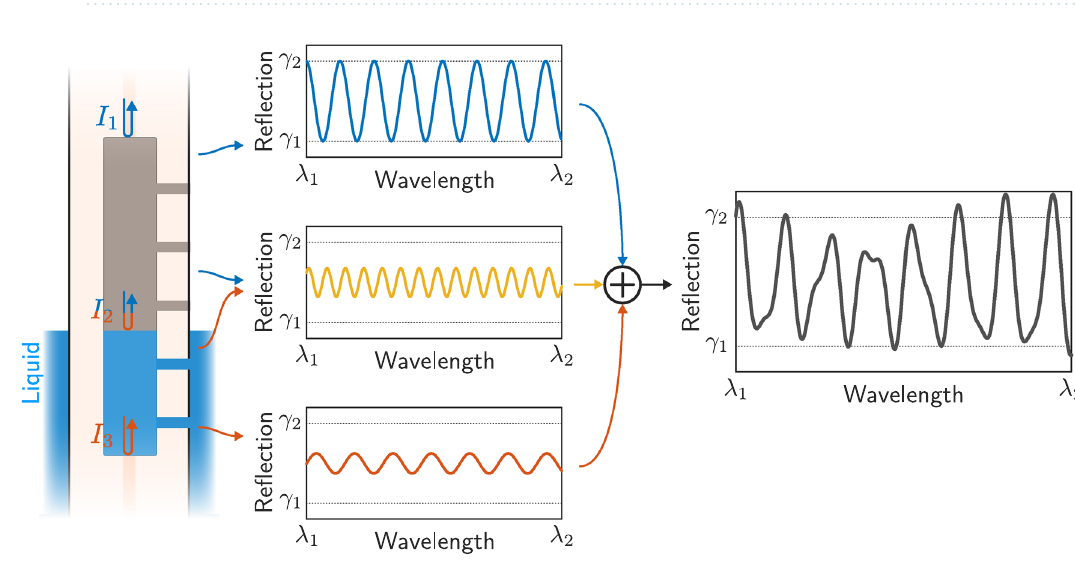
50 objective lens) of the processed HCF, with the square Figure 3. ( a ) Top view microscope image ( × 25 25 μm hole. ( b ) Side view microscope image ( 20 objective lens) of the hole corresponding to the final × × section of the processed HCF. ( c ) Schematic of the fs laser manufacturing process of the holes. 20 planes are made from the fiber surface to the hollow-core. Each plane corresponds to 8 laser scans of 25 μm in length.